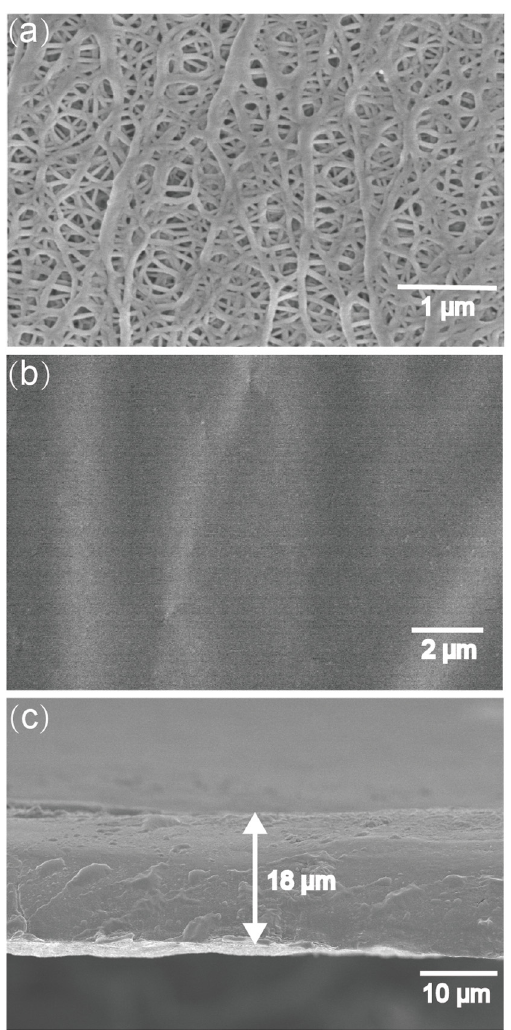
Figure 2. SEM images of ( a ) PE and ( b ) PE − 50%LCE@PEG gel polymer electrolyte. ( c ) Cross − section SEM image of PE − 50%LCE@PEG gel polymer electrolyte.